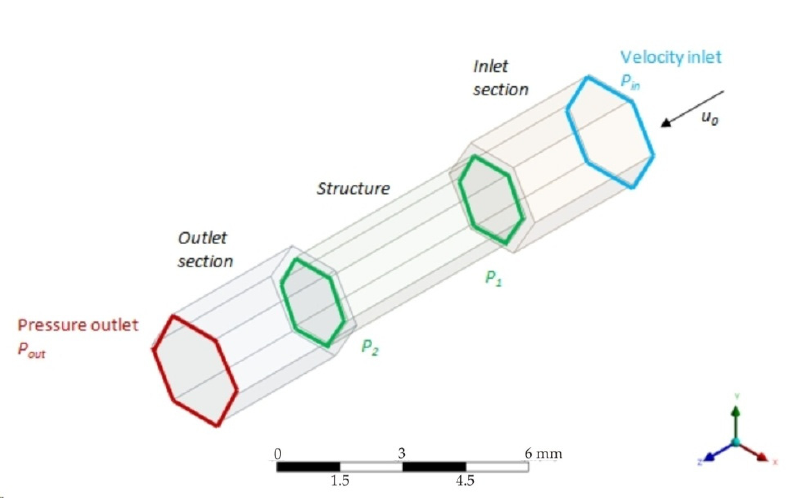
Figure 11. Computational domain of real model with boundary conditions for pressure drop cal-